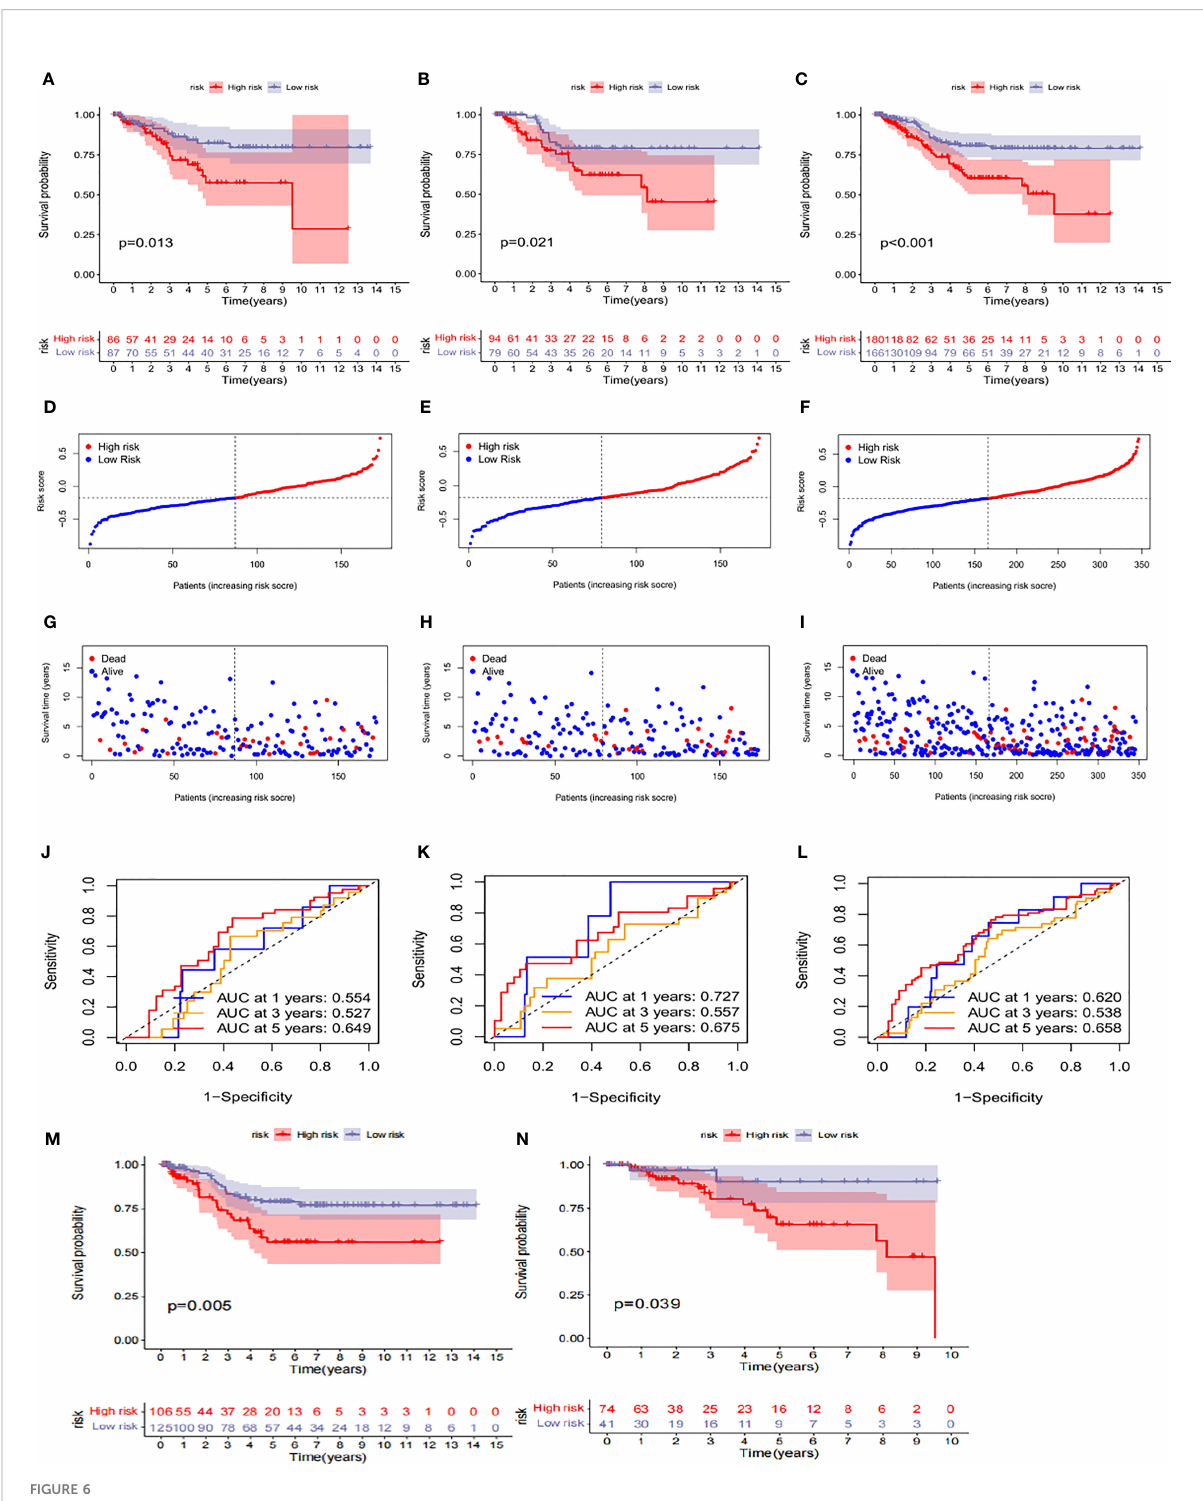
FIGURE 6 Prognosis value of the risk model in the train, test, and entire sets (A – C) Kaplan – Meier survival curves of survival probability of patients between low-and high-risk groups in the train,test, and entire sets, respectively. (D – F) Exhibition of CRGs model based on risk score ofthe train, test, and entire sets, respectively. (G – I) Survival time and survival status between low-and high-risk groups in the train, test, and entire sets, respectively. (J – L) ROC curves to predict the sensitivity and speci fi city of 1-, 3-, and 5-year survival according to the CRG_score in the train,test, and entire sets, respectively. (M, N) Survival probability in the high-risk and low-risk subgroups of the GEO cohort and TCGA cohort,